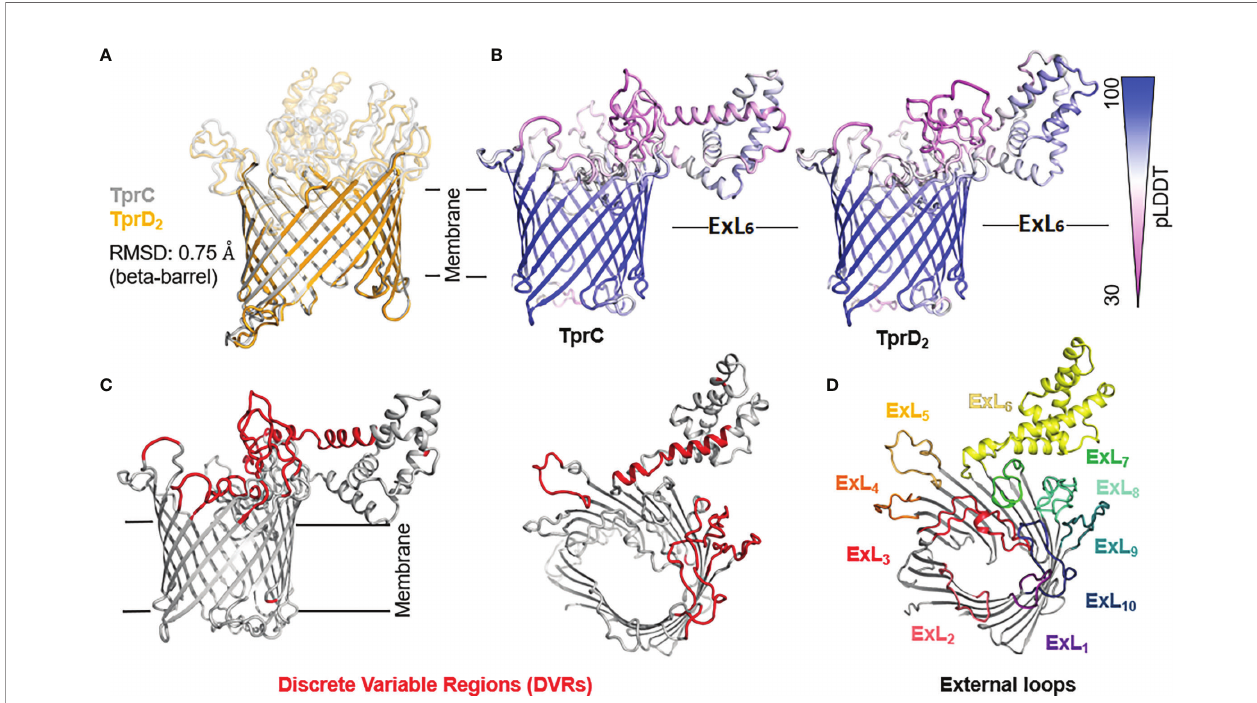
FIGURE 2 | Predicted structures of TprC and TprD 2 using AlphaFold2. TprC and TprD 2 sequences were obtained from the Sea81-4 genome (NZ_CP003679.1/ CP003679.1). (A) Both TprC and TprD 2 are predicted to fold into similar 20-strands beta-barrels structures. The predicted structures are nearly identical in the transmembrane region (backbone RMSD = 0.75). (B) Compared to the scaffolding, slightly lower con fi dence in the structural models for TprC and TprD 2 are seen in the external loop regions based on the per-residue model con fi dence (pLDDT) mapped on the predicted TprC and TprD 2 structures, suggesting structural fl exibility for these regions. Noteworthy, however, is that the largest loop (ExL7) is predicted to have a similar helical-rich structure in both TprC and TprD 2 . Full pLDDT analysis for TprC and TprD 2 is reported in Figure S3 . (C) The DVRs (in red on the TprC model structure) identi fi ed by aligning TprC and TprD 2 sequences of different strains ( Figure 1 ) mostly localize in the predicted extracellular loops. (D) AlphaFold identi fi ed ten surface-exposed external loops (ExLs). Discrete variable regions (DVRs) based on Figure 1 alignments are predicted to be in ExL1, ExL5-6 and